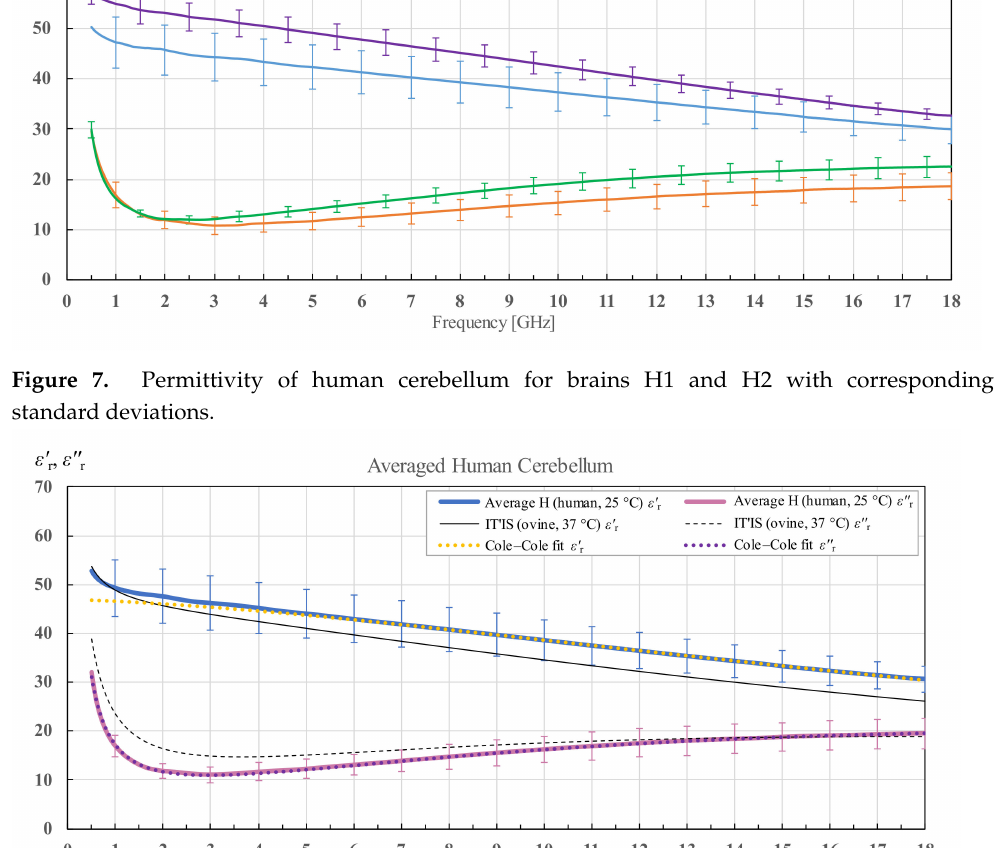
Figure 8. Average permittivity of human cerebellum with standard deviation and Cole–Cole fit, shown in comparison with the data from IT’IS database